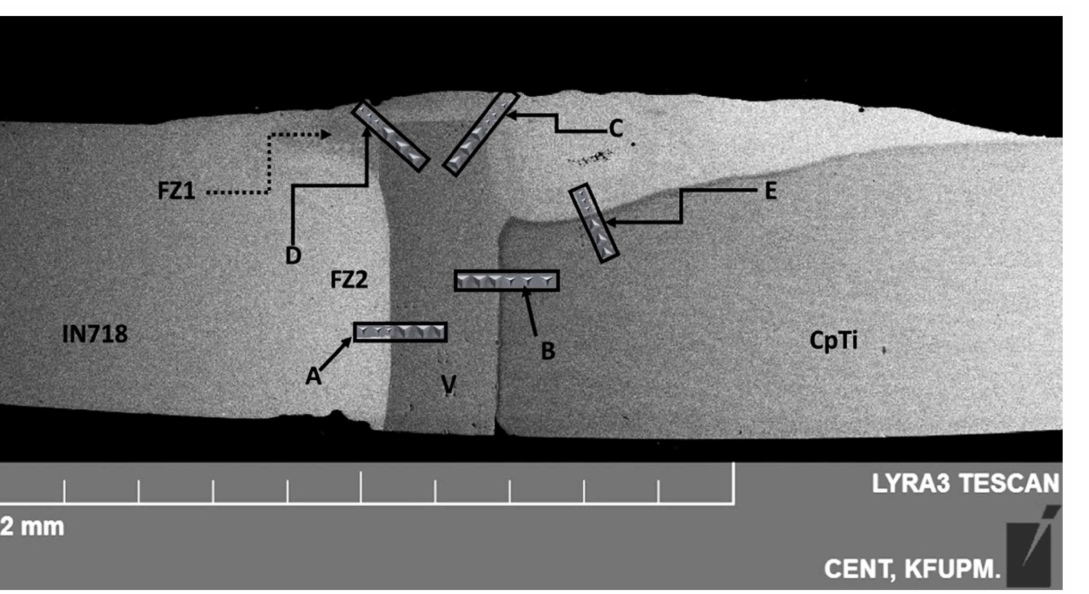
Figure 8. Locations selected for nanohardness line scans across the CpTi/V/IN718